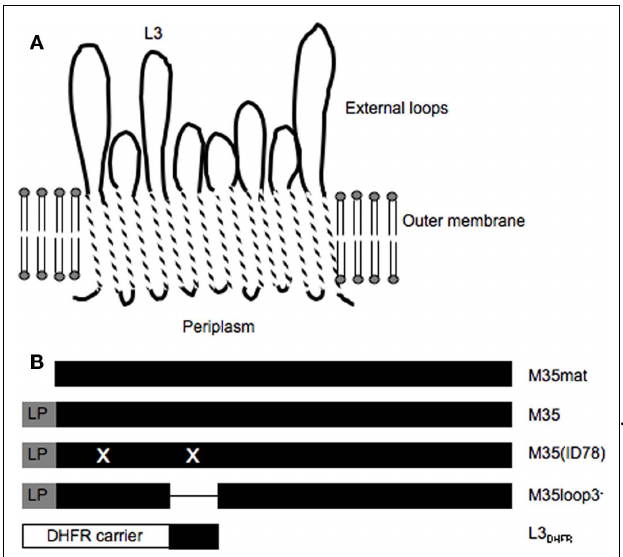
FIGURE 1 | Diagramatic representation of the structure of M35 and the M35-derived recombinant proteins. (A) Schematic of M35 showing the relative lengths of the external loops. (B) Relative sequence inclusions of the recombinant protein constructs. LP, leader peptide and X, amino acid substitution. M35mat does not include the leader peptide; M35 is the full sequence including the leader peptide; M35(ID78) includes the two amino acid substitutions present in M35 from isolate ID78LN266 when compared to the consensus, which are valine to isoleucine at position 32 and glycine to aspartic acid at position 133; M35loop3 − does not include the loop 3 region; L3 DHFR is the loop 3 region of M35 attached to the DHFR carrier.